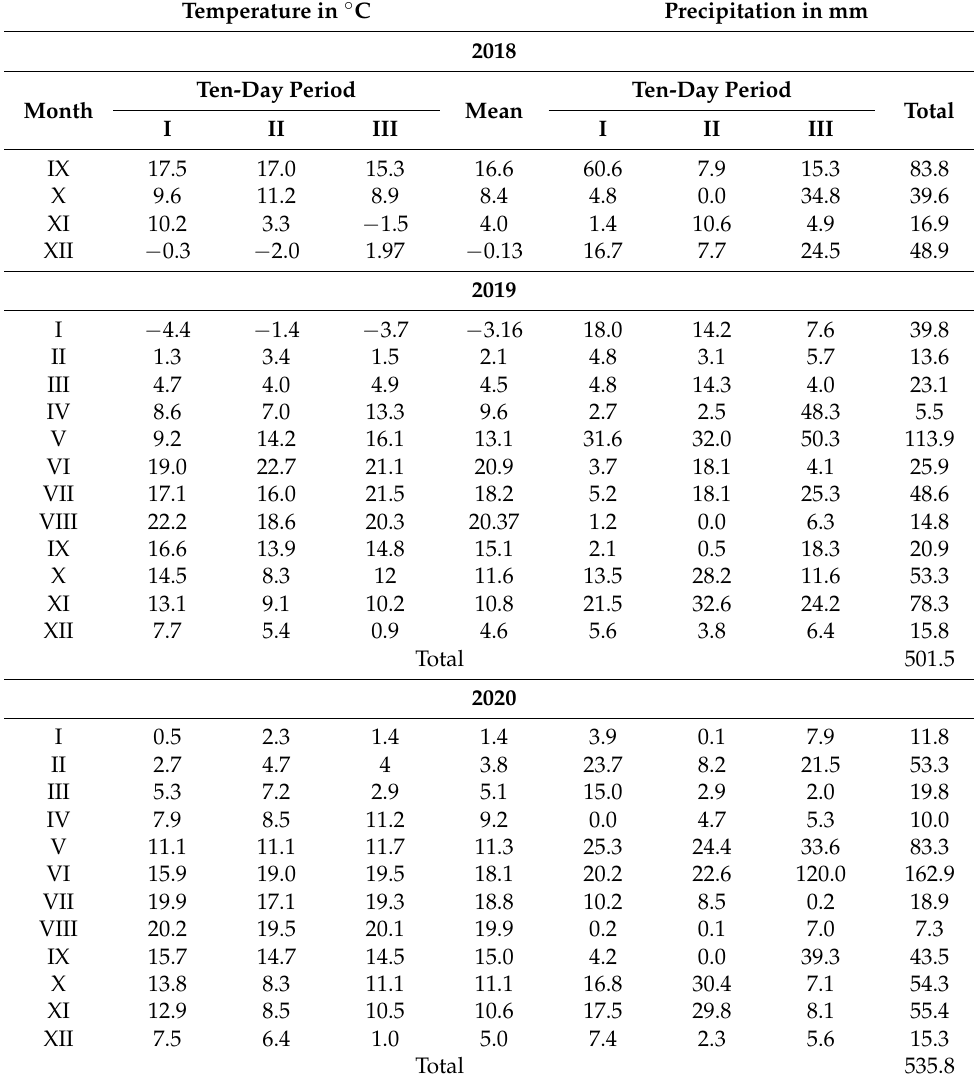
Table 3. Weather conditions in 2018/2019 and 2020 provided by the Meteorological Station of the University of Rzesz ó w. Temperature in ◦ C Precipitation in